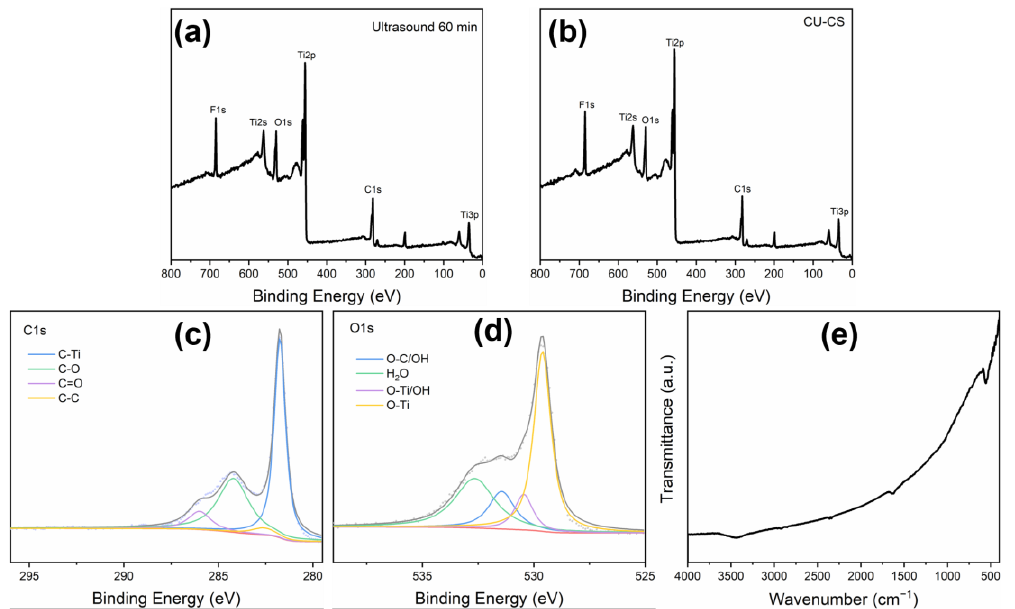
Figure 4. ( a ) The XPS results of the Ti 3 C 2 T x MXene nanosheets obtained with ultrasound for 60 min; ( b – d ) The XPS results of the Ti 3 C 2 T x MXene nanosheets obtained with CU-CS; ( e ) The